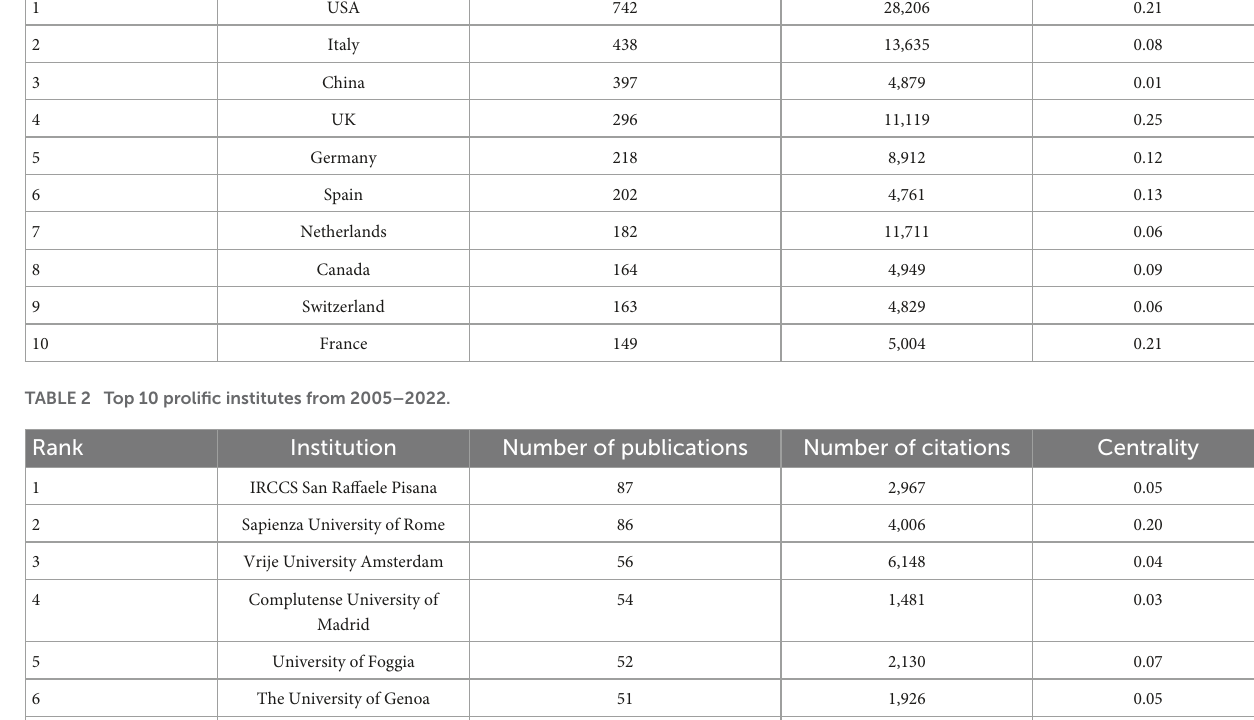
TABLE 1 Top 10 countries/regions with the highest number of publications from 2005 to 2022.